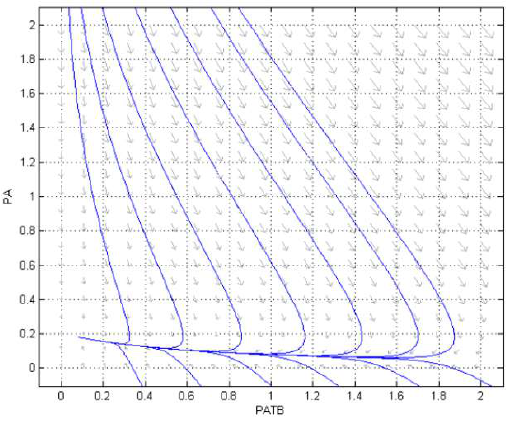
Figure 6. Trajectory of P ATB and P A . Figure 5 indicates that individuals suffering from HIV suffer from TB also, and both the compartments stabilize after some time. Figure 6 shows that individuals in the pre-AIDS class also suffer from TB. The trajectory is stable.